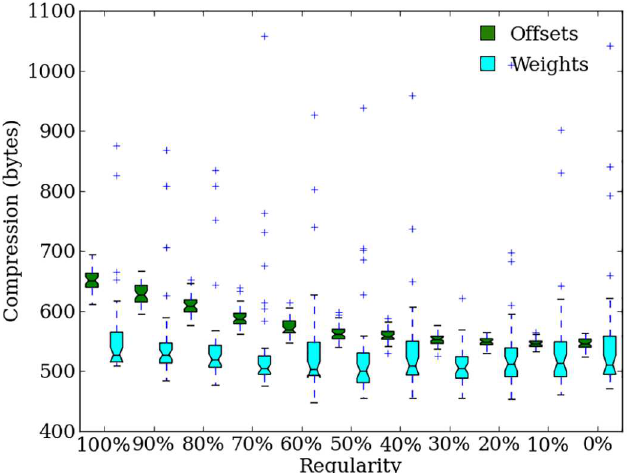
Fig 10. The compressibility of directly encoded offsets and CPPN-generated weights in bytes for Offset-HybrID run champions after 2,000 generations on the target weights experiment higher numbers = more compressible. Offsets are green and CPPN-generated weights are light-blue.